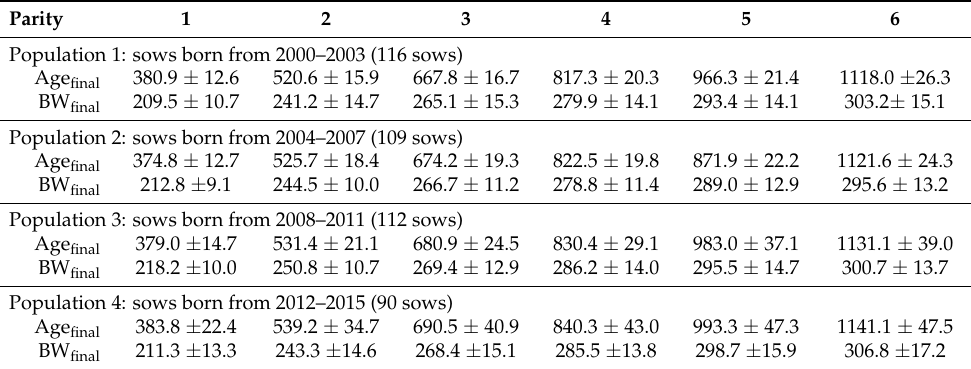
Table 2. Mean ± standard deviation of age (Age fianl , d) and body weight (BW final , kg) at farrowing in Large White × Landrace sows studied from parity 1 to 6, depending on the population in the herd (i.e., year of birth).